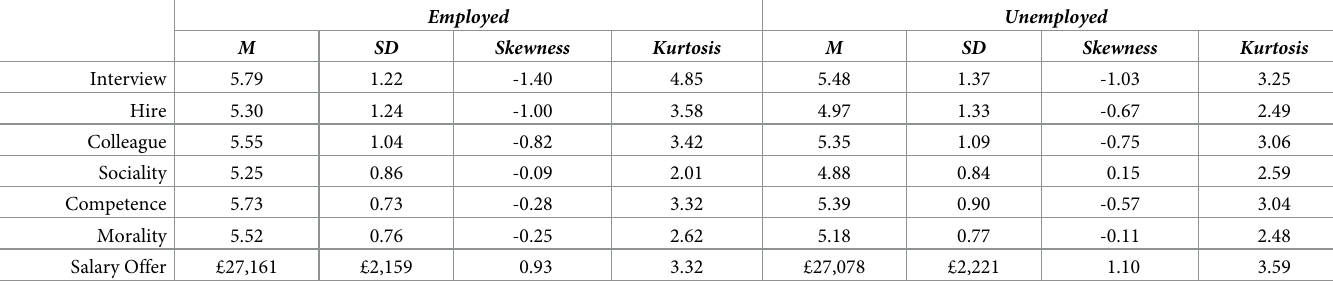
Table 3. Descriptive statistics for dependent variables as a function of CV.